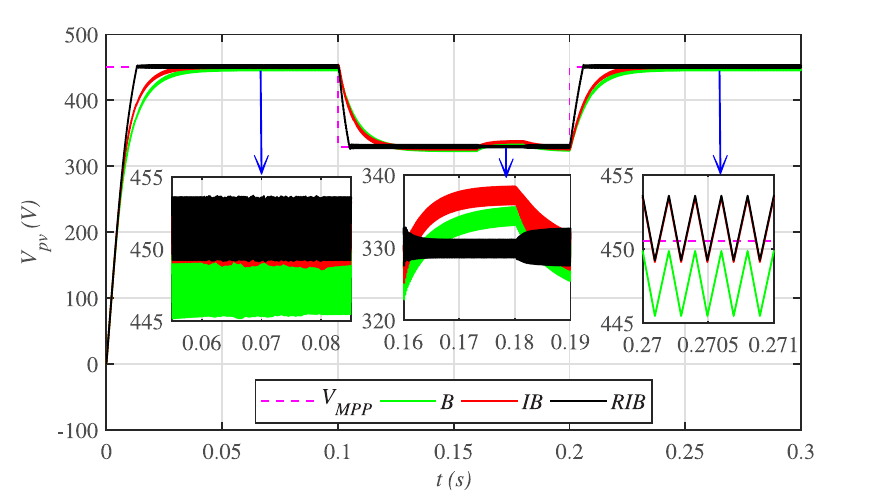
Fig 22. PV array output comparative voltages under case 3.